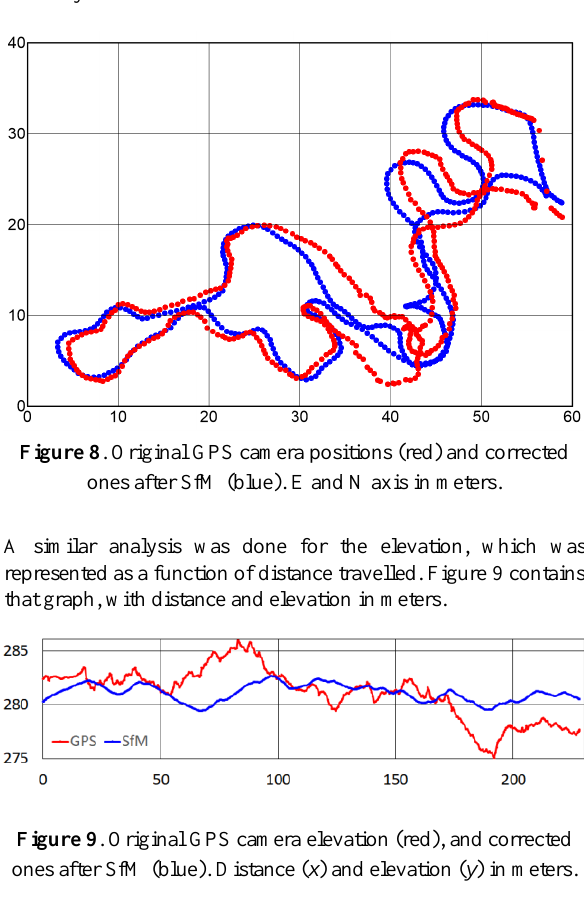
Figure 7 . Positions of image acquisition in one of the sets. The image alignment is done, with camera self-calibration, in order to obtain the complete orientation of the images. The points in the levelling staff and in the building walls are identified in the images where they are better seen. Camera GPS positions and the adjusted ones after the SfM processing were plotted, in order to assess the changes. Figure 8 represents the two sets of camera positions: in red the original and in blue the new ones. Differences are of few meters, normally less than 3 m.